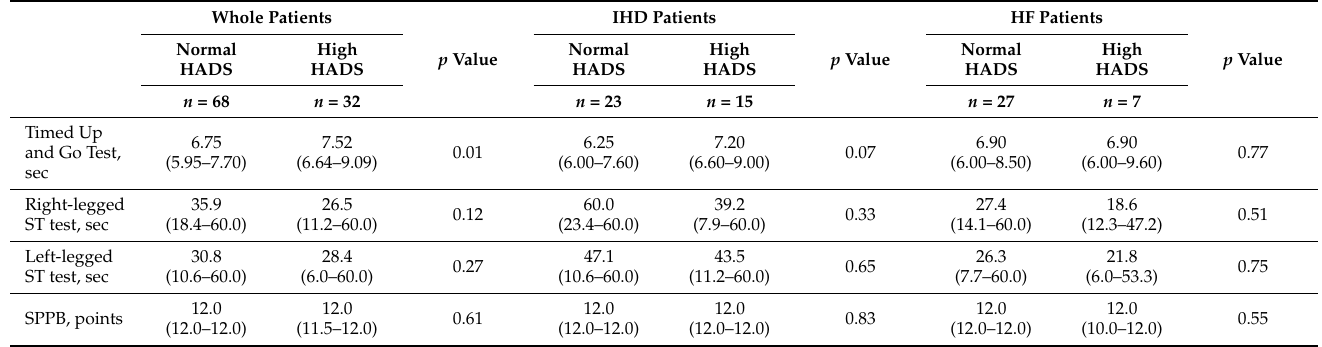
Table 3. The differences of several physical activity tests between normal HADS group and high HADS group in whole patients, IHD patients, and HF